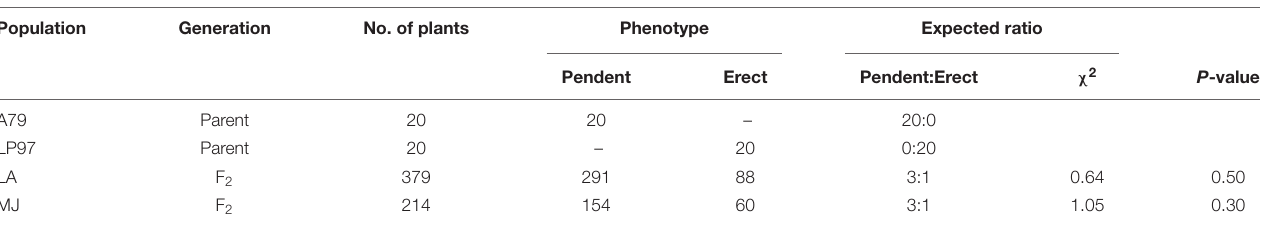
FIGURE 1 | Pedicel curvature and fruit orientation phenotype. (A) Pedicels with different positions of curving, marked with red asterisks. (B,C) Vertically upright (left) Capsicum annuum ‘micropep’, C. annuum ‘U92’ and vertically pendent (right) C. annuum ‘Jeju,’ C. annuum ‘A106’ fruit types. (D) Cross-section view of an erect (straight) pedicel with a uniform distribution of cells across the surface (top) and a pendent pedicel at the point of curvature (bottom), where the abaxial cells (Ab) are on average 2.6 × more compacted than the cells on the adaxial side (Ad). Co, collenchyma; Ph, phloem; X, xylem; Pi, pith. TABLE 2 | Segregation analysis of fruit orientation for the LA and MJ